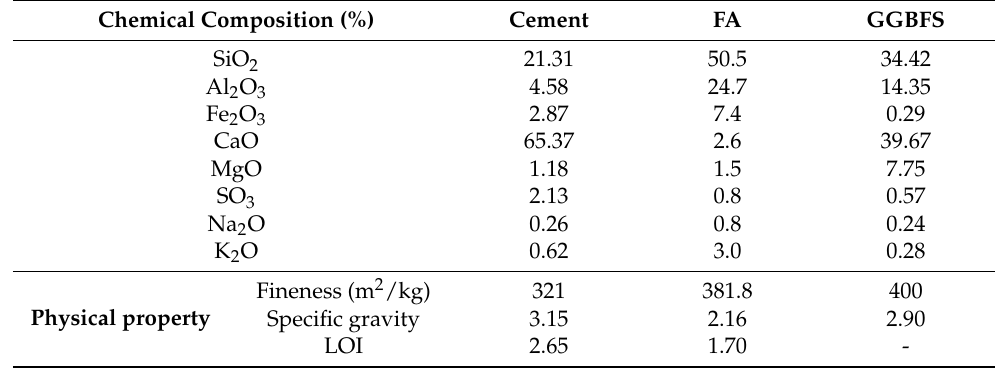
Table 1. Basic composition analysis of cementitious materials of green and ecofriendly grouting material (wt.%).